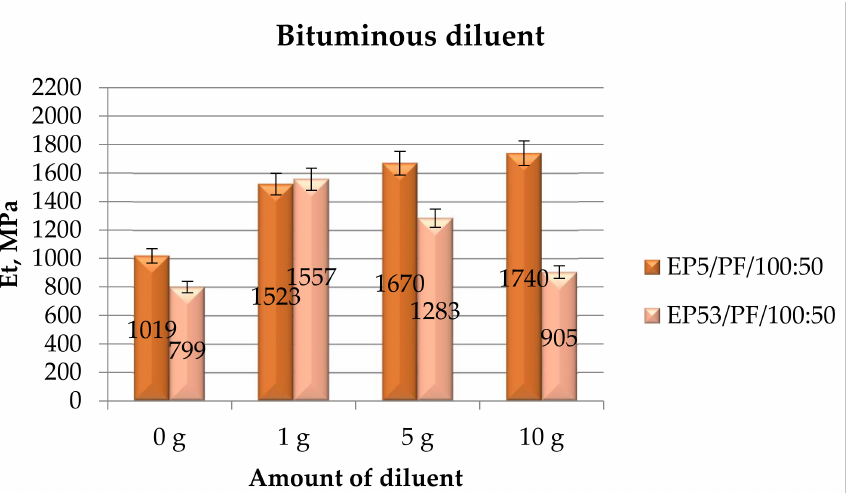
Figure 16. Tensile modulus calculated for Epidian 5 and Epidian 53 epoxy compounds as a function of the amount of bituminous diluent.